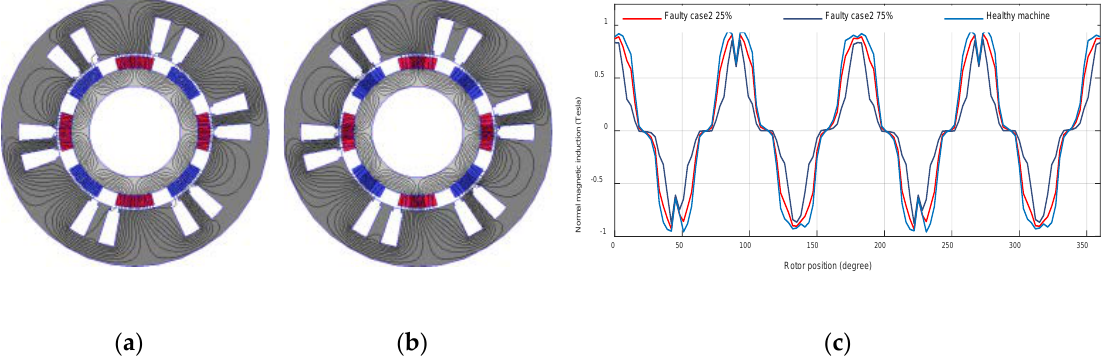
Figure 7. Faulty case 2: ( a ) Magnetic field under 25%; ( b ) magnetic field under 75%; ( c ) airgap magnetic flux density.